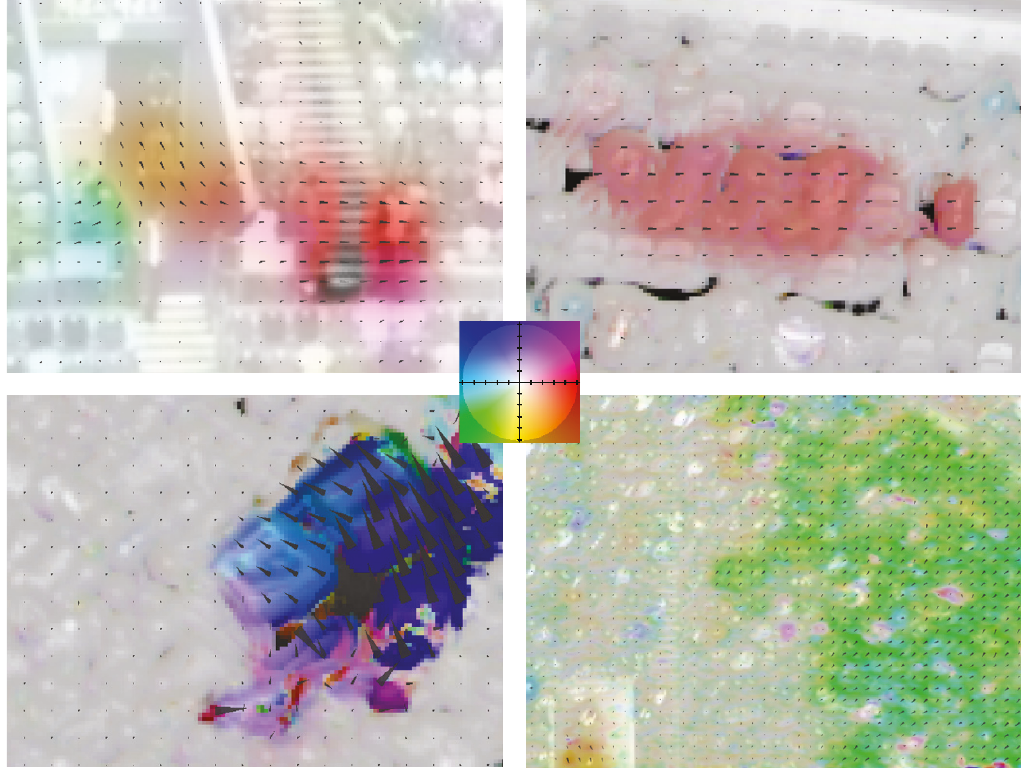
Figure 10: Optical flow has been estimated using the proposed neural architecture to process sample image sequences from video surveillance scenario acquired in a soccer stadium. Here, movement of single persons and groups of people is detected and integrated for di ff erent typical scenarios, such as single persons entering the stadium (top left), groups of people leaving the seating area (top right), the classification of salient events like flag waving (bottom left), and the flow estimation for a group of jumping people (bottom right). The motion is again displayed in the direction color code of the palette given in the